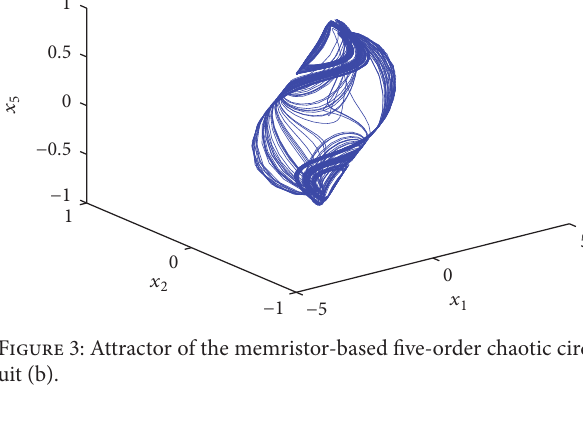
Figure 3: Attractor of the memristor-based five-order chaotic circ- uit (b).